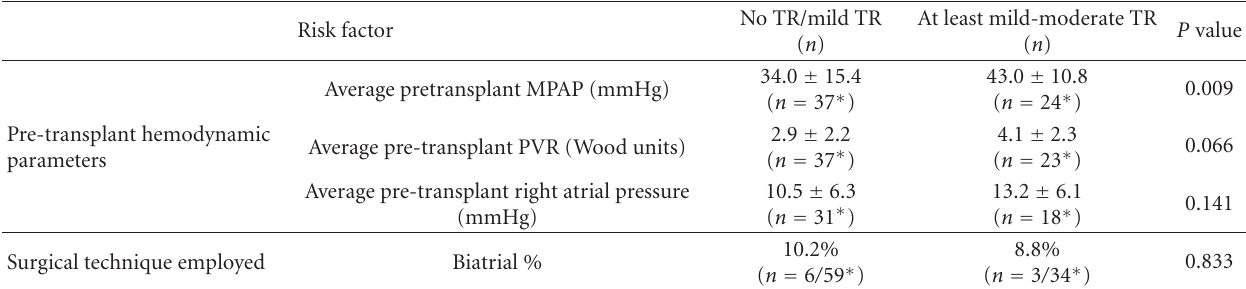
Table 2: A univariate analysis of risk factors for early significant (at least mild-moderate) TR.